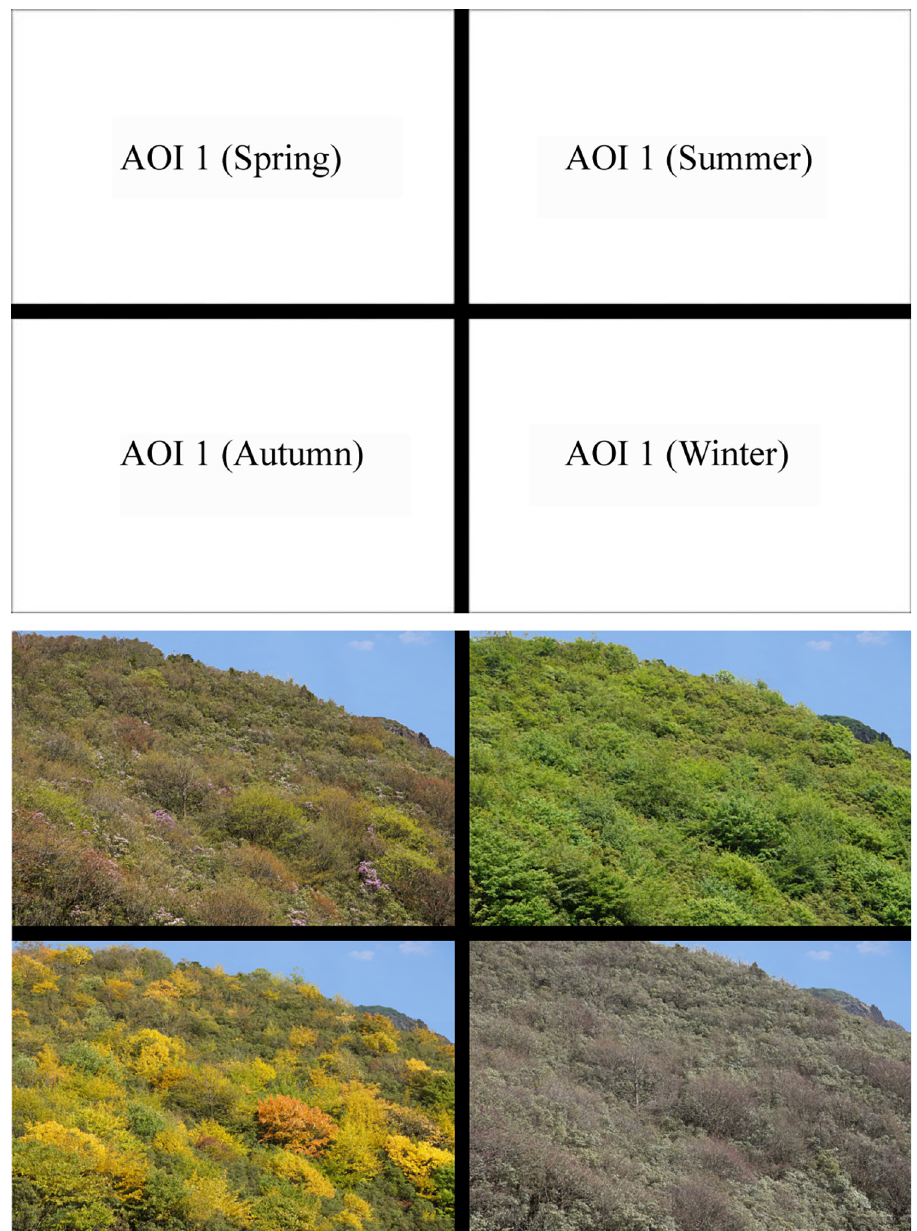
Fig 2. Contrast photos of forest color in the four seasons. (A) Before filling before filling. (B) Contrast pictures after season’s contrast image was divided into four areas of interest, with the spring, summer, autumn, and winter forest color photos each corresponding to one area of interest (Fig 2). In addition, in order to avoid the preference impact of a different sky, we use Adobe Photoshop CC (2019, Adobe, San Jose, CA, United States) software to change the sky part of each four- season comparison picture into the same blue sky and white cloud. A total of 30 four-season comparative pictures were included in the experiment, including one preparation picture before the experiment and 29 formal photos of the experiment.